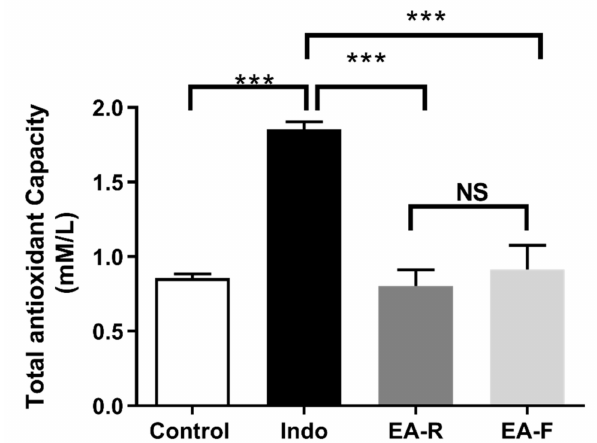
Figure 9. Bar graph showing the e ff ect of indomethacin, pure EA and optimized EA formula on serum total antioxidant capacity. Data are presented as mean ± SEM. *** Significantly di ff erent at p < 0.001. Indo: indomethacin, EA-R: pure ellagic acid, EA-F: ellagic acid